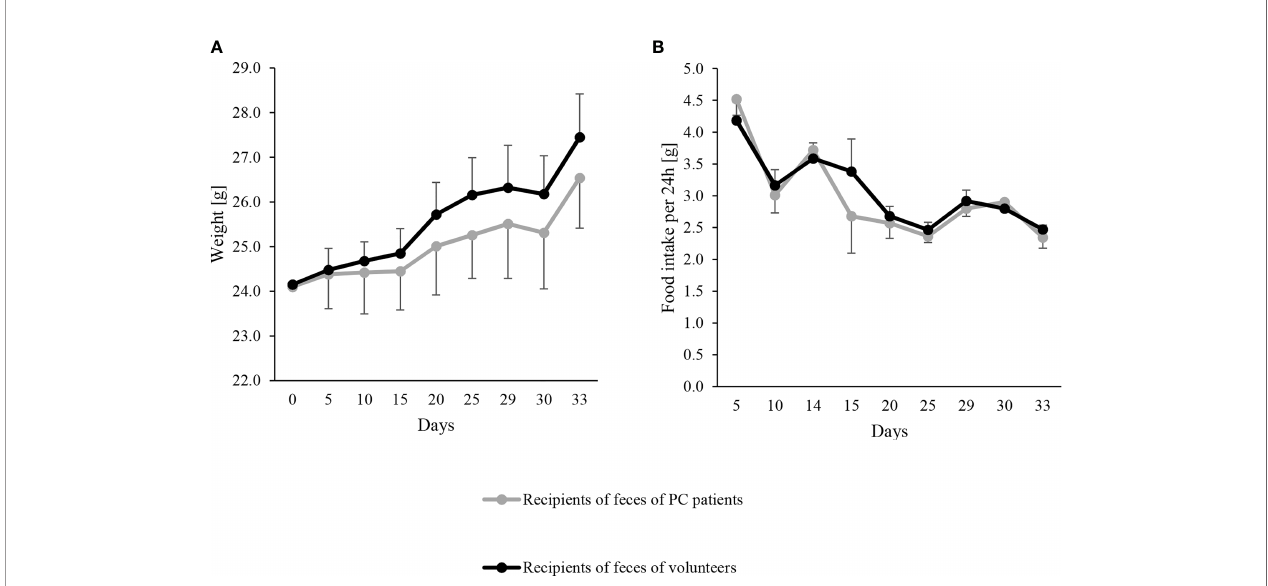
FIGURE 1 | Evolution of body weight (A) and food intake (B) in the mouse recipients of feces from pancreatic cancer (PC) patients as mean – SD (gray line) (n = 10) and volunteers as mean + SD (black line) (n = 10). FMT were performed on day 0, 2 and 6. Body weight at each time point was never signi fi cantly different between both groups by linear regression models (all p >